Question: Does the plotted quantity increase or decrease?
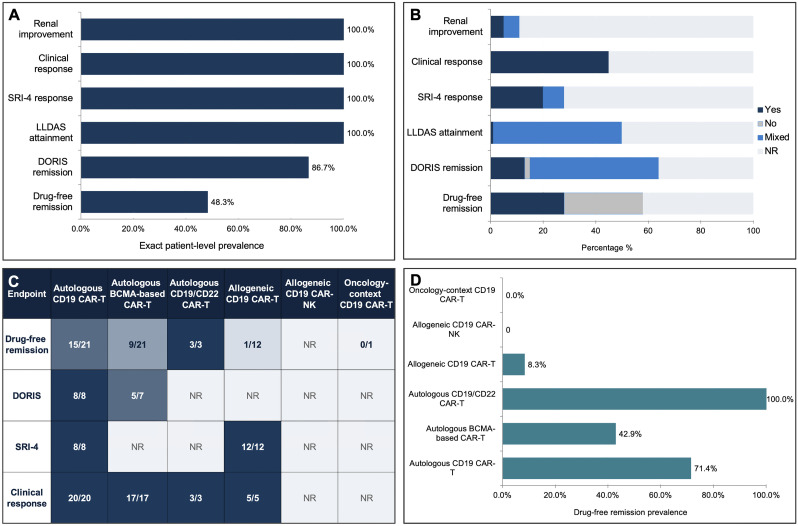
Answer: increasing